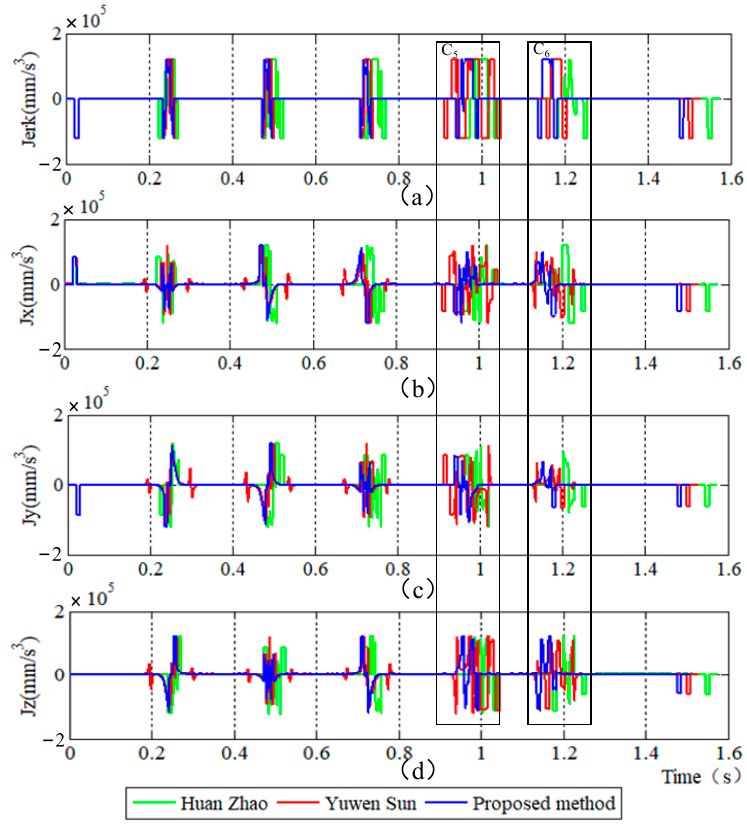
Figure 12. Jerk profiles of 3D tool path.